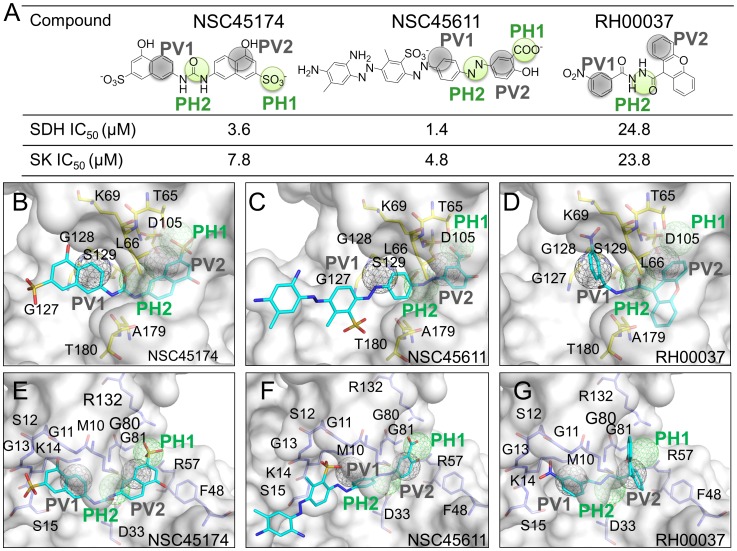
New multitarget inhibitors identified by the pathway-based screening strategy.(A) The compound structures and IC50 values of the multitarget inhibitors. The relationships between the inhibitors and the pathway anchors are represented by green (hydrogen-bonding interactions) and gray (van der Waals interactions) circles. Docking poses of these inhibitors and anchor residues of (B–D) SDH and (E–G) SK.